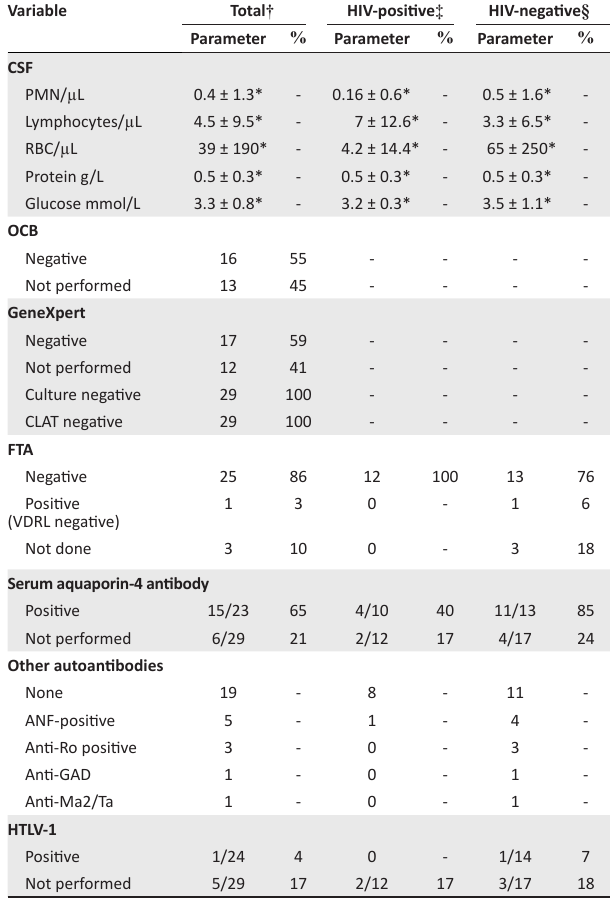
TABLE 2: Laboratory